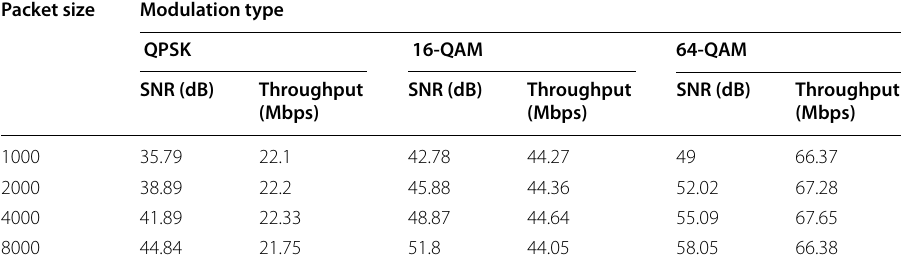
Table 6 SNR and corresponding throughput values for various packet sizes in the MDP‑CLLA model Packet